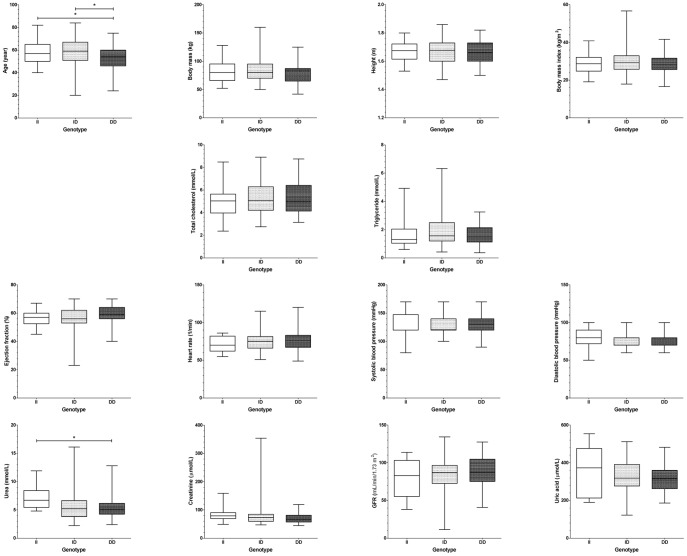
Correlation of patient's parameters with ACE I/D genotype.Various parameters (age, body mass, height, body mass index, total cholesterol, triglyceride, ejection fraction, heart rate, systolic and diastolic blood pressure, urea, creatinine, glomerular filtration rate and uric acid) were correlated to the genotype of the patients (insertion, II, n = 28; deletion, DD, n = 52 and heterozygotes, ID, n = 71). The boxes indicate the interquartile range with median; whiskers are the minimum and the maximum values. Significant differences (1 way ANOVA, Bonferroni post-hoc test) are labelled by asterisks.